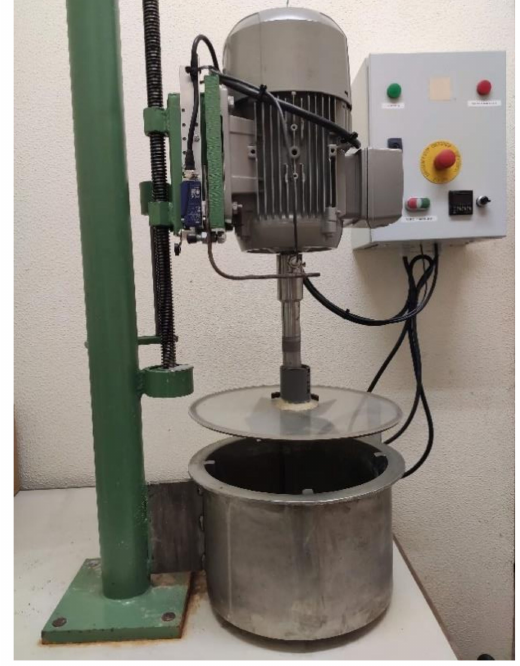
Figure 1. Slurry